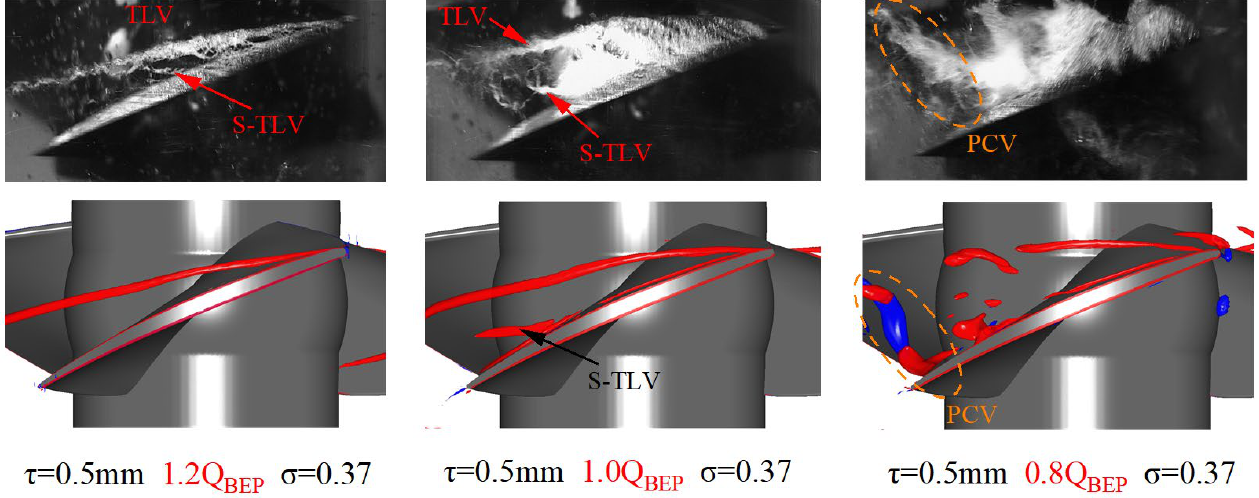
Figure 23. Cavitation images and vortex isosurface (Liutex R = 1000, Red ─ circumferential vortex, Blue ─ axial vortex) under different flow rates.